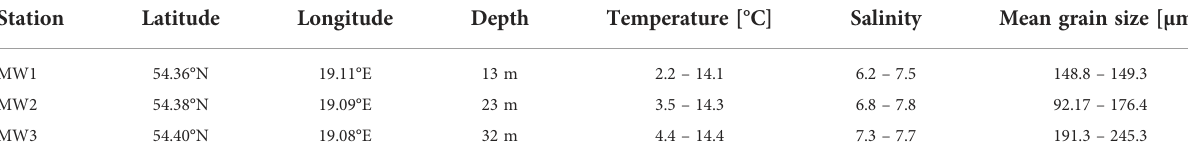
TABLE 1 Geographic coordinates and environmental conditions for each sampling station in the Vistula prodelta.